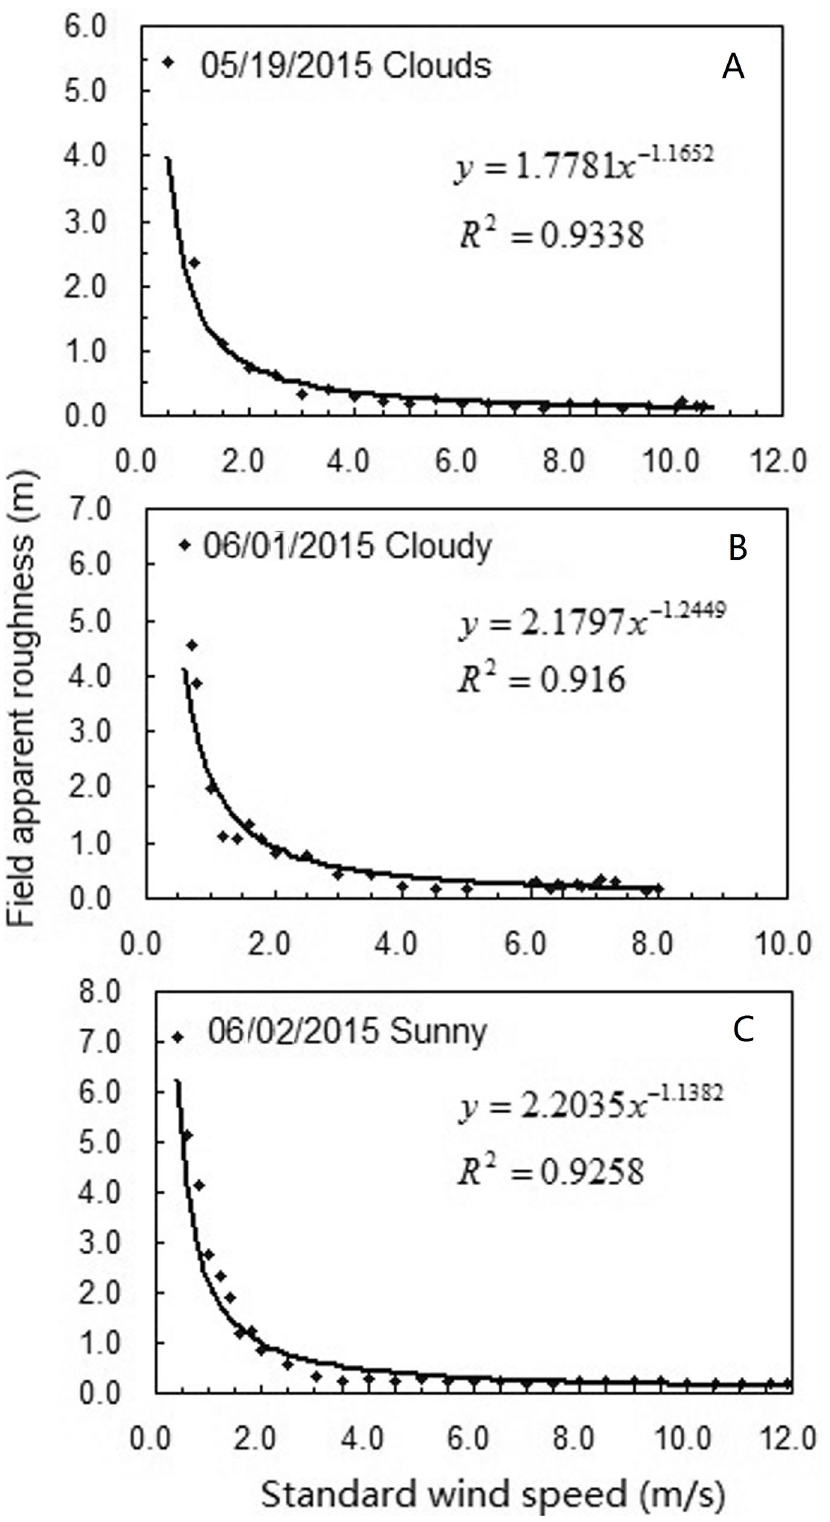
Fig 5. The relationship between the wind speed and the apparent roughness at the near surface layer of the wheat field.